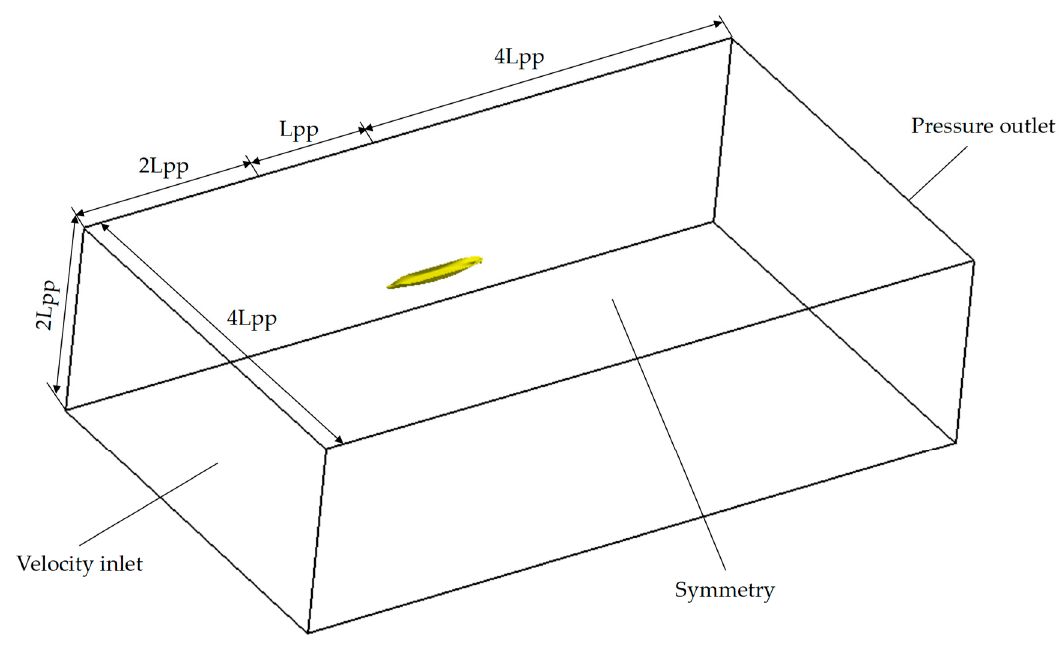
Figure 3. The computational domain and boundary conditions.